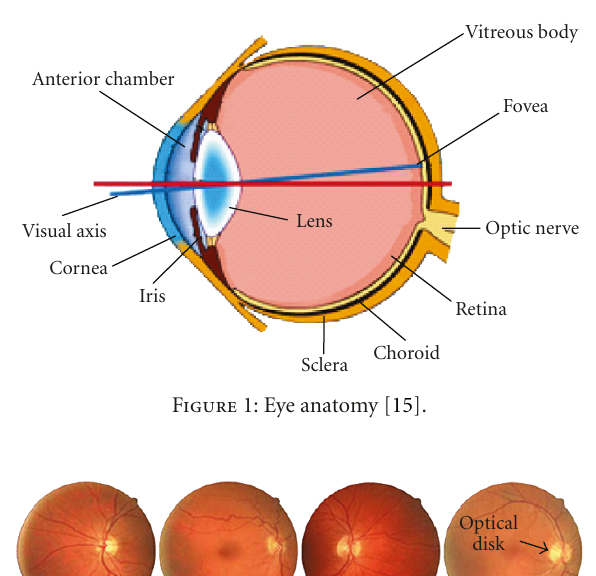
Figure 2: Retina images from four di ff erent